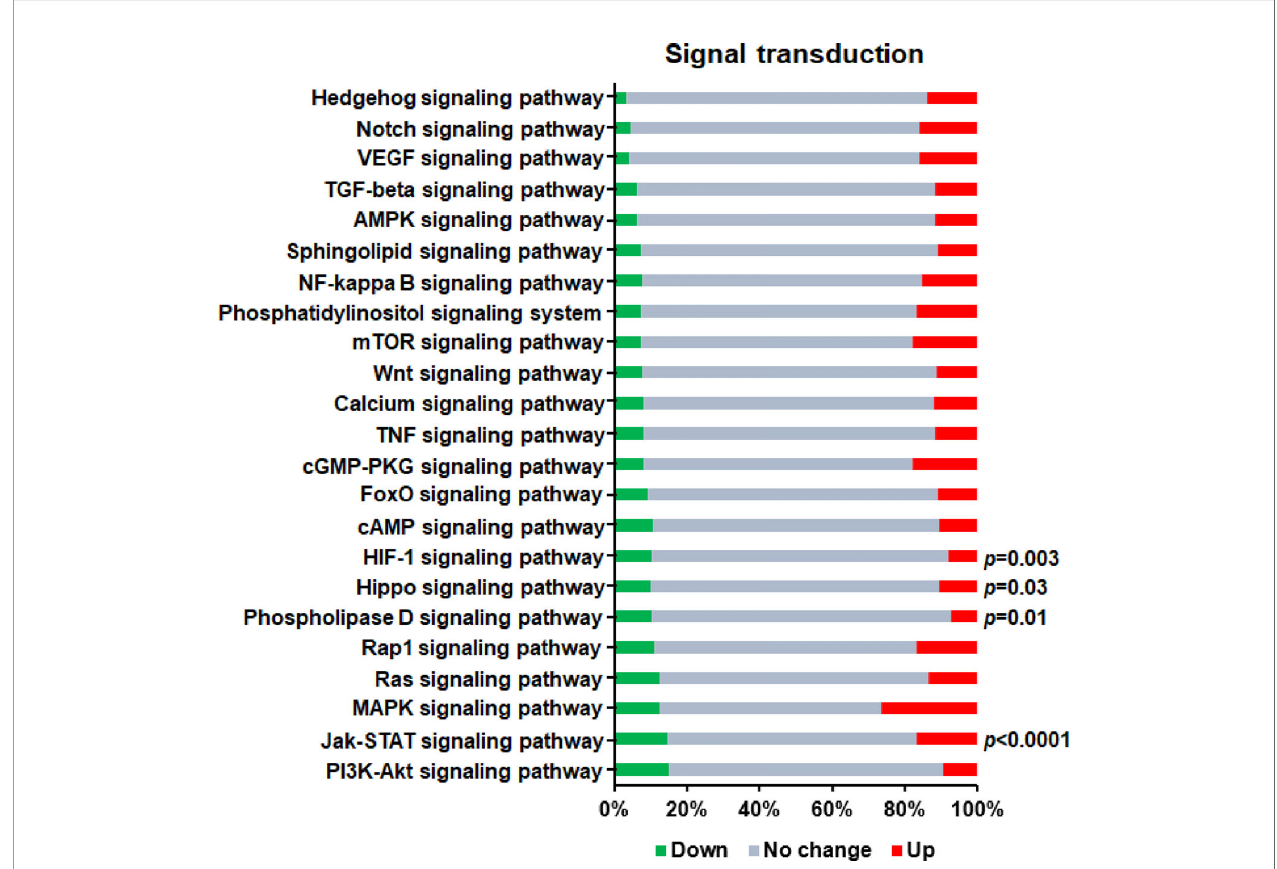
FIGURE 5 | KEGG enrichment analysis of DEGs in signal transduction pathways related to Th1 cell differentiation. Red bars represent up-regulated genes, green bars represent down-regulated genes, and gray bars represent unchanged